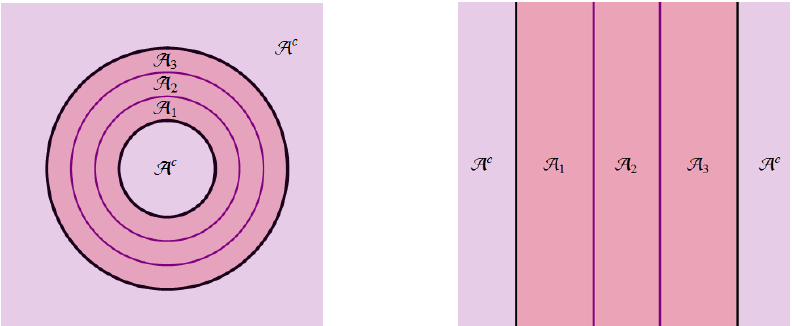
Figure 6 . Quasi-one-dimensional con(cid:12)gurations with rotation and translation symmetries. Here A = A 1 [ A 2 [ A